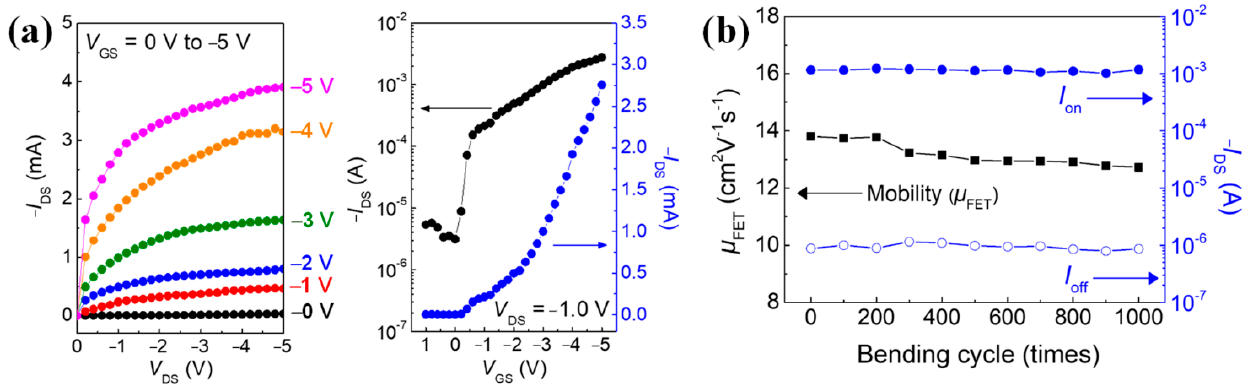
Figure 10. ( a ) Output and transfer characteristics of the textile-OFET using P3HT/EEG nanocomposite as an active channel material. ( b ) Changes in the field-effect mobility and on and off currents of the textile-OFET developed using P3HT/EEG nanocomposite as dependent on bending cycles (bending radius = 1.5 cm). Table 1. Average field-effect mobilities, on–off current ratios, and threshold voltages for textile- OFETs based on P3HT and P3HT/EEG nanocomposite as active channel materials.